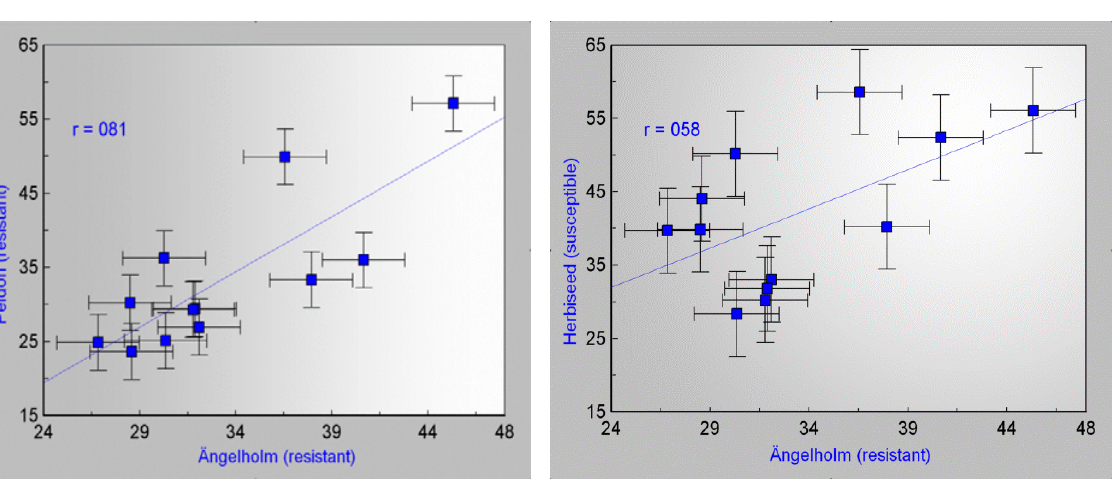
Figure 2. Relationship between potential allelopathic activity of a herbicide-resistant black-grass biotype from Ängelholm and the herbicide-resistant biotype Peldon from Essex ( left ), and the relationship between the resistant biotype from Ängelholm and the herbicide-susceptible biotype from England ( right ). Bars indicate two standard errors (SE). r denotes the linear correlation coefficients and it is significant if r > 0.57 ( P <